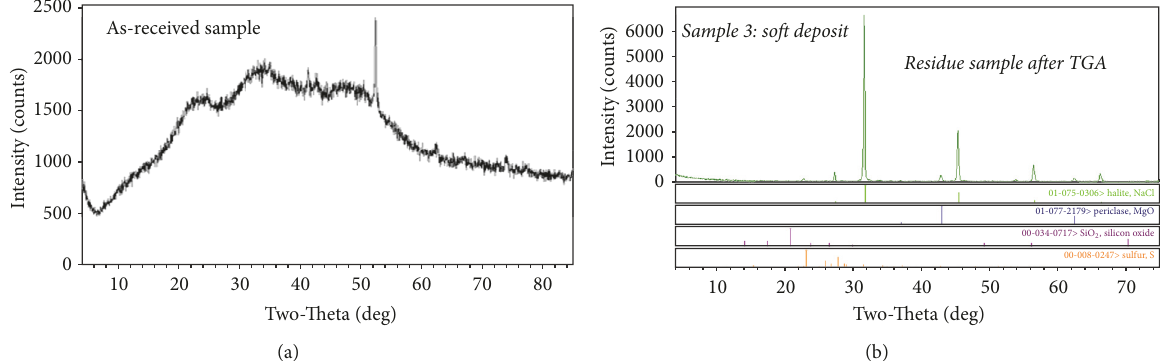
Figure 9: XRD phase identification results along with the standard reference mineral. (a) The sulfur recovery unit 1 and (b) the residue soft deposit sample after thermal gravimetric analysis along with the identified phases, halite [NaCl], periclase [MgO], silicon oxide [SiO 2 ], and